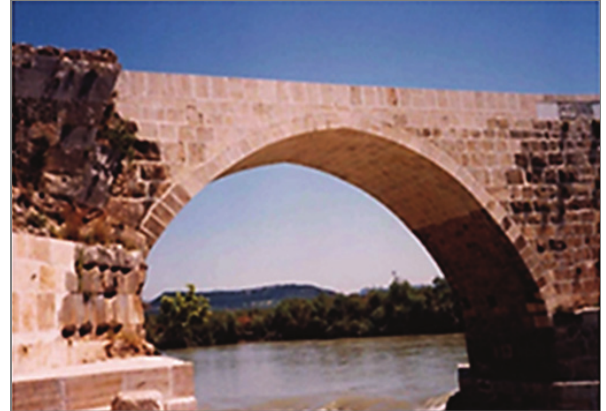
Fig. 1. Present-day use of travertine in the renovation of historical engineering objects – Belkis bridge (Turkey) (photo by J. Pini ń ska)